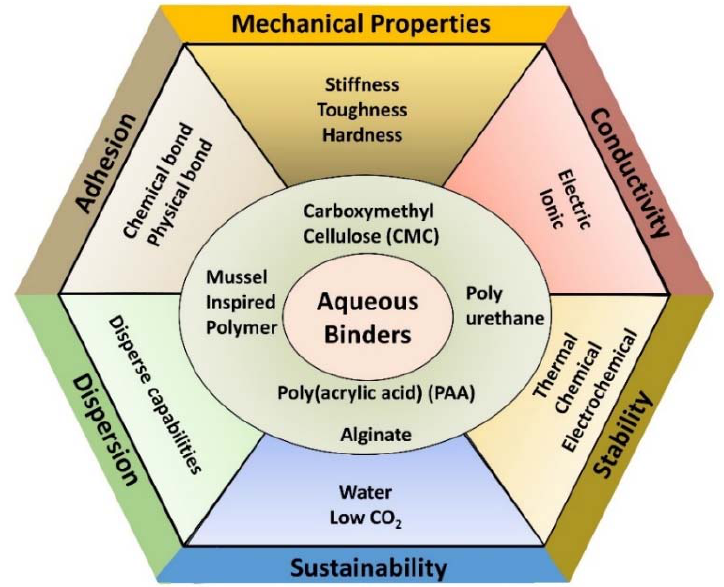
Figure 2. Requirements and desired properties of binders in energy storage devices. Aqueous binders can address many of these requirements, with several examples shown in the center.